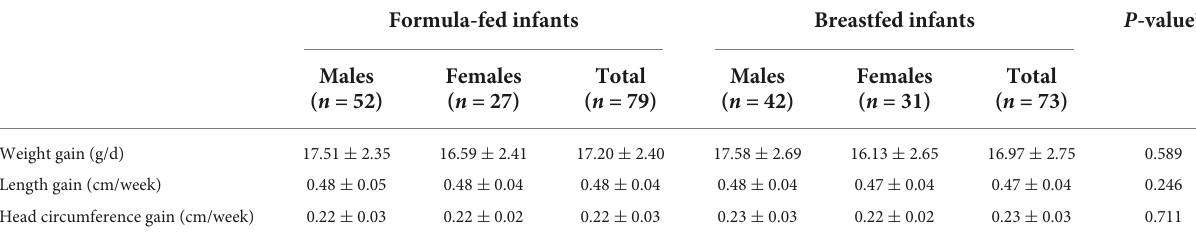
TABLE 3 Mean ± SD growth velocity from enrollment to study end (i.e., 12 months of age) by feeding group and sex (FAS population). Formula-fed infants